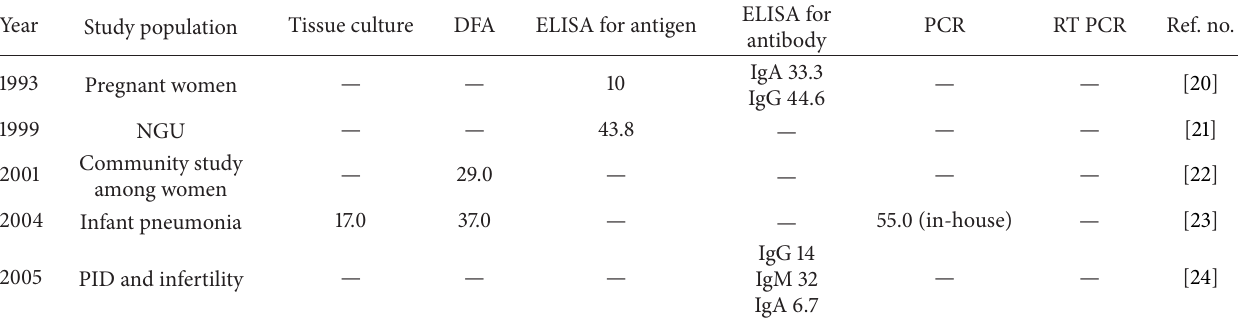
Table 1: Diagnostic methods for